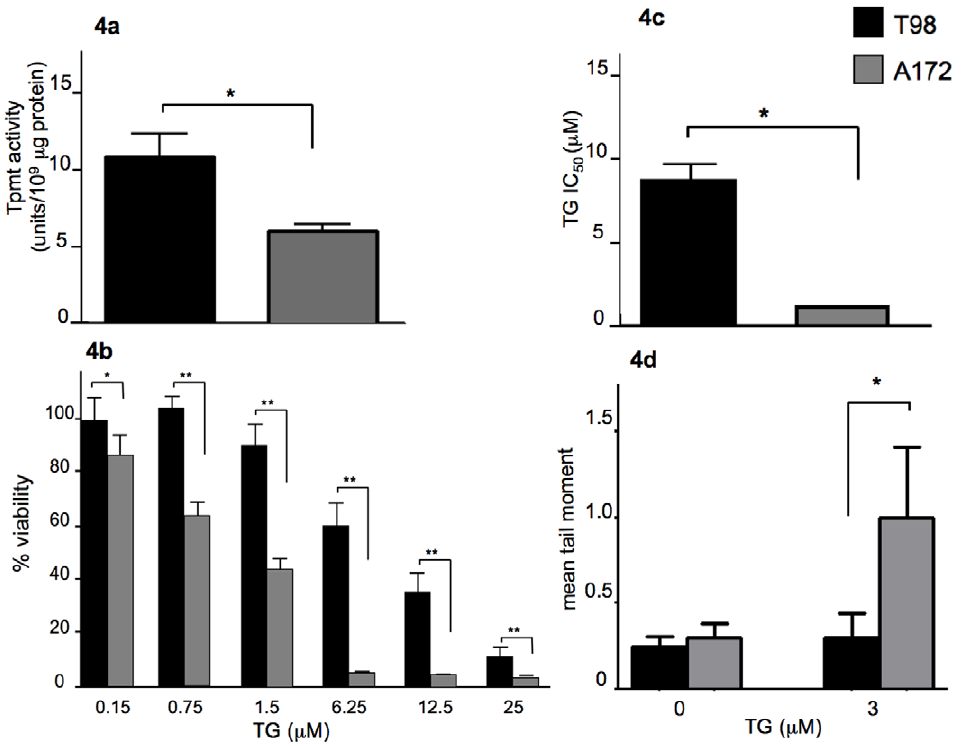
Figure 4. Assessment of Tpmt-associated phenotypes in model astroglial cell lines. Tpmt protein activity was measured in T98 and A172 glioma cell lines. (a) T98 displayed a significantly higher level of protein activity than A172 (p , 0.05). (b) As observed in primary astrocyte cultures, low Tpmt protein activity is associated with greater cytotoxicity as determined by the MTT assay; (c) and reflected in IC 50 values. A172 had a significantly more sensitive at all TG concentrations and lower IC 50 than T98 (p , 0.05). (d) The alkaline comet assay was used to compare TG-induced DNA damage. A172 displayed a significantly greater degree of TG-induced DNA strand breaks than T98 (p=0.02) as measured by mean comet tail moment. Bars represent the means; whiskers represent the standard deviation ( 6 ); * p , 0.05; ** p ,